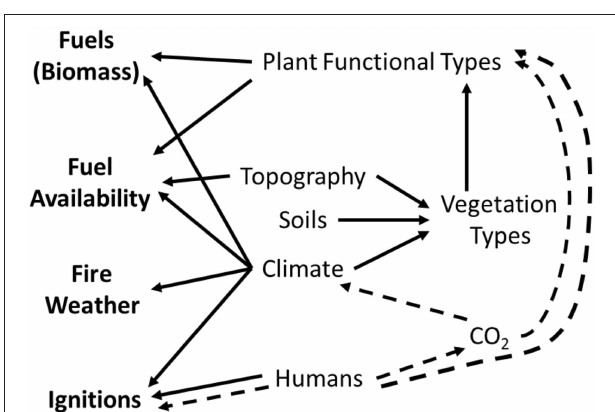
FIGURE 1 | Influences of abiotic and biotic factors (climate, soils, vegetation types, plant functional types) on fire regimes via four “switches” (fuels, fuel availability, fire weather, and ignitions). Potential effects of changing climate, human activity, and atmospheric CO 2 are indicated by dashed lines. Figure modified from Bradstock